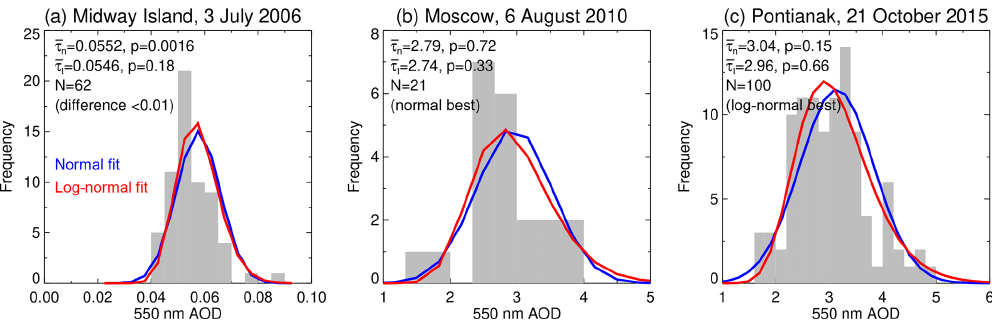
Figure 5. Histograms (grey) of 550nm AOD observed at three AERONET sites on individual dates (given in panel titles), corresponding to different SW test classification results. Arithmetic- and geometric-mean AOD ( ¯ τ n , ¯ τ l , respectively), p values for the SW test for the respective distributions, number of points, and category are also given for each case. Bin sizes are site-dependent. Normal and log-normal fits to each histogram are shown in blue and red, respectively.